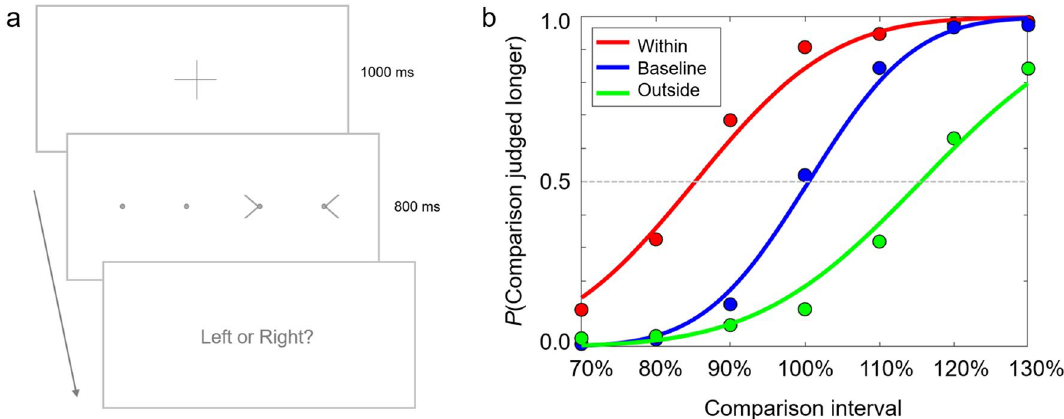
Figure 1. Overview of methodology. (a) Schematic illustration of the sequence of an experimental trial. (b) Participants’ binary responses were used to construct psychometric functions. The examples shown are the average functions from Experiment